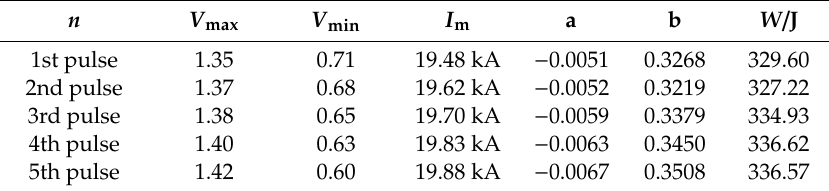
Table 5. Impact energy of the sample under five pulses.